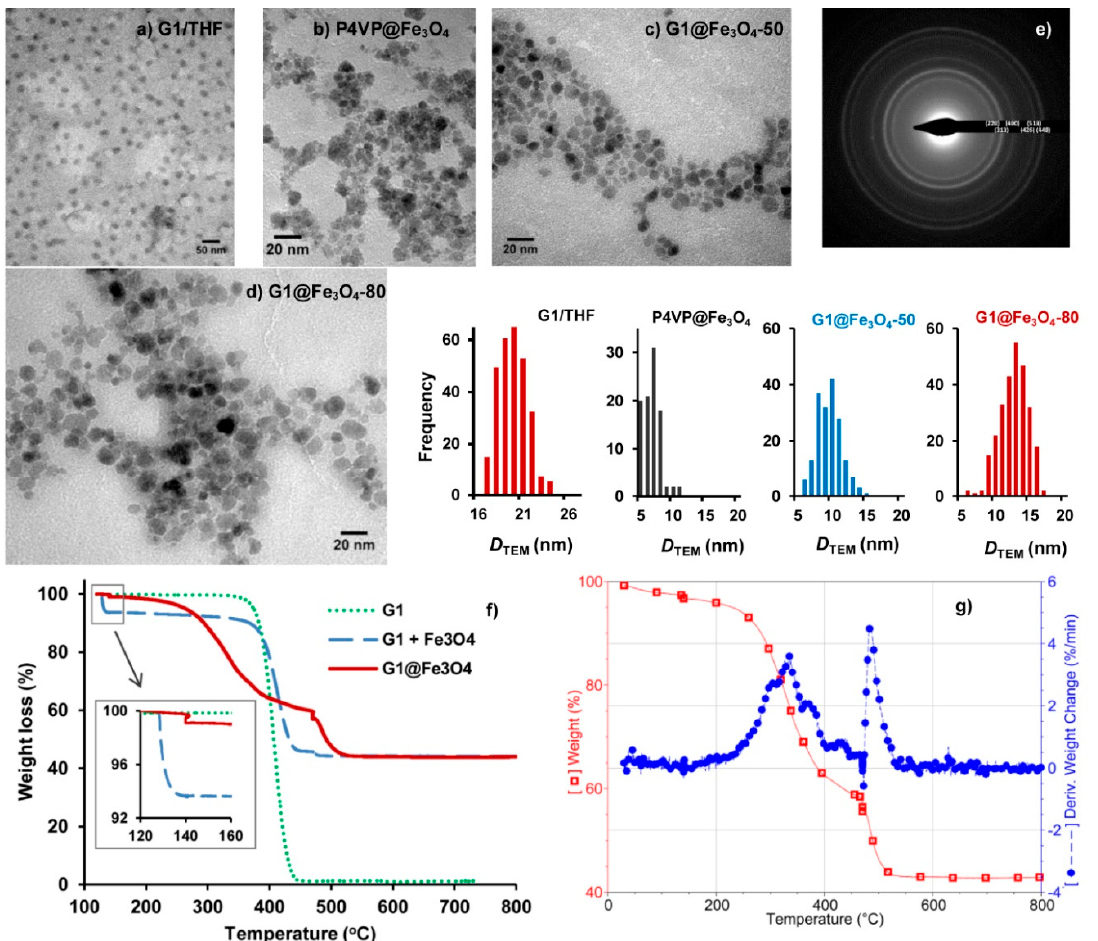
Figure 2. ( a ) TEM image of G1 arborescent PS- g -P2VP micelles. Crystallites of Fe 3 O 4 NPs synthesized in the presence of ( b ) linear P4VP chains at 50 °C, ( c ) G1 at 50 °C and ( d ) G1 at 80 °C. ( e ) SAED for G1@Fe 3 O 4 with assignment of diffraction rings to the Bragg peaks for Fe 3 O 4 . ( f ) TGA curves for pure G1 template (green, dotted), a mixture of dry G1 and Fe 3 O 4 (blue, long dash) and G1@Fe 3 O 4 (red, solid). ( g ) Weight loss (red, ) and differential of the weight loss curve (blue, ) for G1@Fe 3 O 4 .